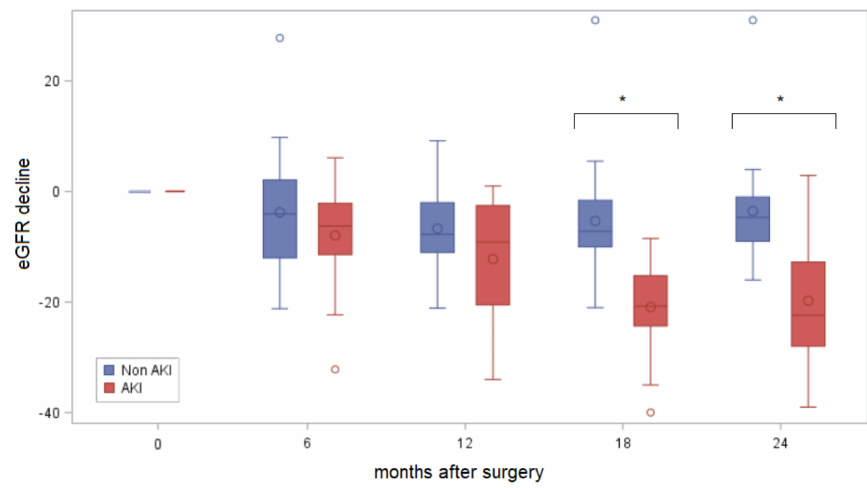
Figure 3. Estimated glomerular filtration rate (eGFR) decline at 6, 12, 18 and 24 months after surgery. * The median eGFR decline at 18 and 24 months after surgery was significantly faster in patients who experienced postoperative AKI. AKI; Acute Kidney Injury. eGFR in mL/min/1.73 m 2 , estimated using CKD-EPI